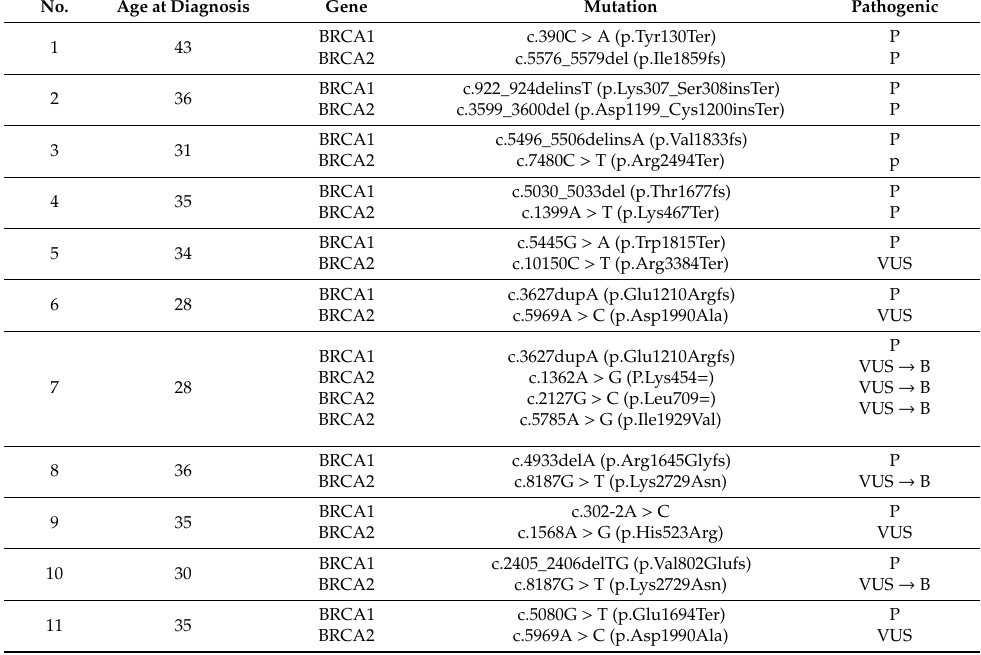
Figure 2. Imaging of patient No. 1 at the first diagnosis of breast cancer in January 2016. ( a ) Breast magnetic resonance imaging (MRI) showed a 2.4 cm lesion in the right breast. ( b ) Breast ultrasound image showed a hypoechoic solid lesion in the right breast. Table 2. Genetic mutations in patients with pathogenic mutations in both gBRCA1 and gBRCA2 and patients with gBRCA1 mutation and gBRCA2